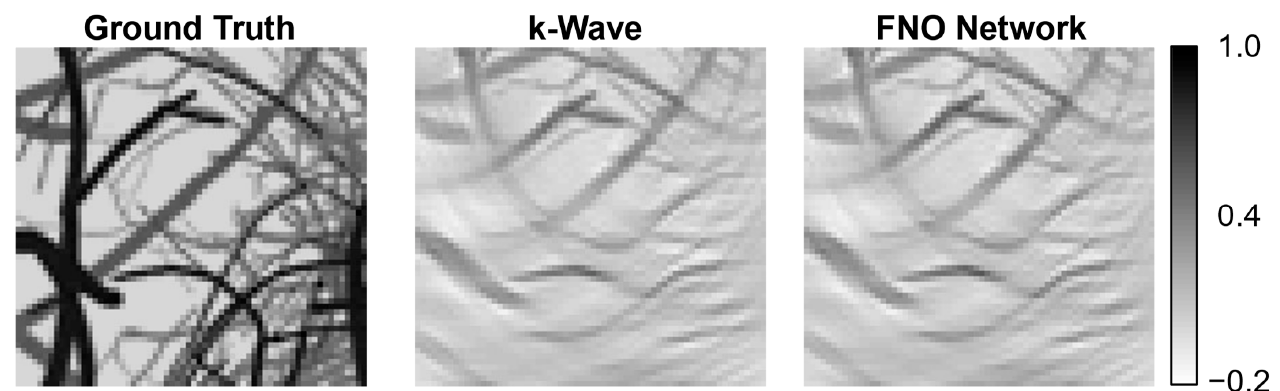
Figure 5. FNO and k-Wave were used to simulate wave propagation for the ground truth image. Sensor data were sampled from the resulting simulations and reconstructed into PAT images. The k-Wave and FNO images are almost identical. RMSE (0.011), SSIM (0.97) and max error (0.06).